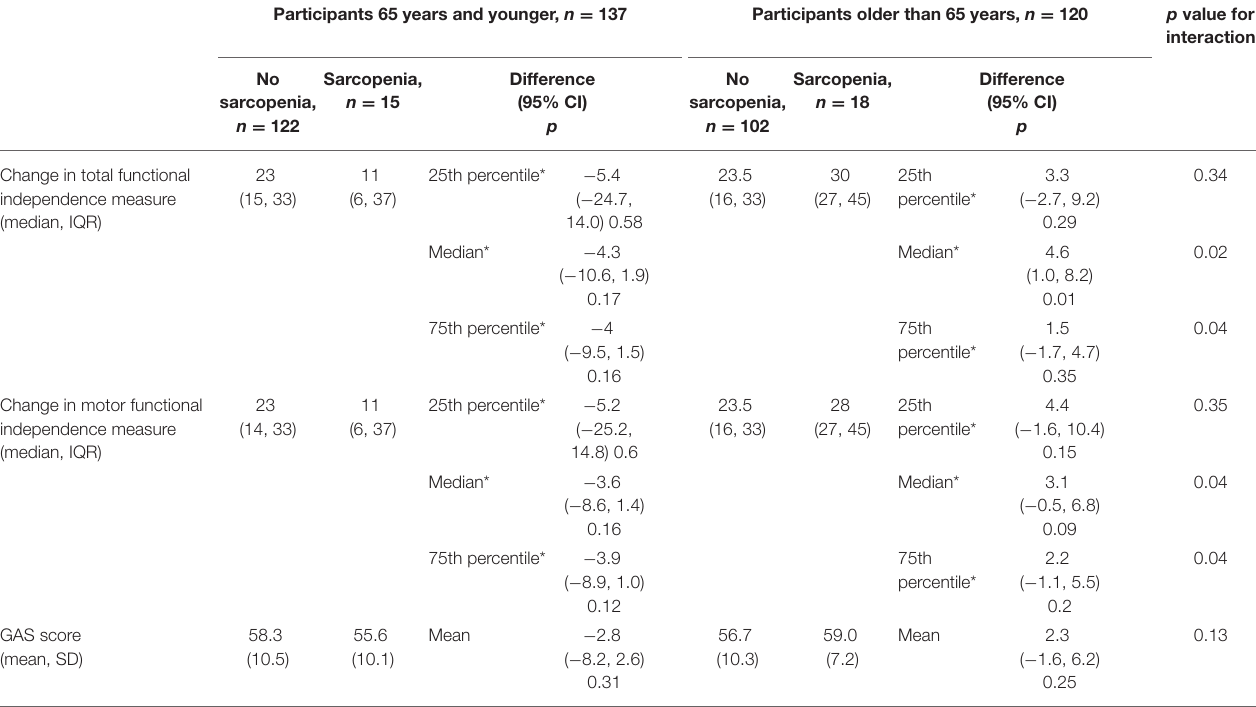
TABLE 2 | Participants’ total functional independence measure (FIM) change, motor FIM change, and Goal Attainment Scaling scores of participants older and younger than 65 years stratified by sarcopenia status.